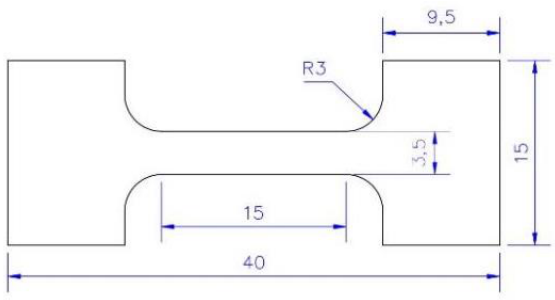
Figure 3. The size of tensile specimen (mm).